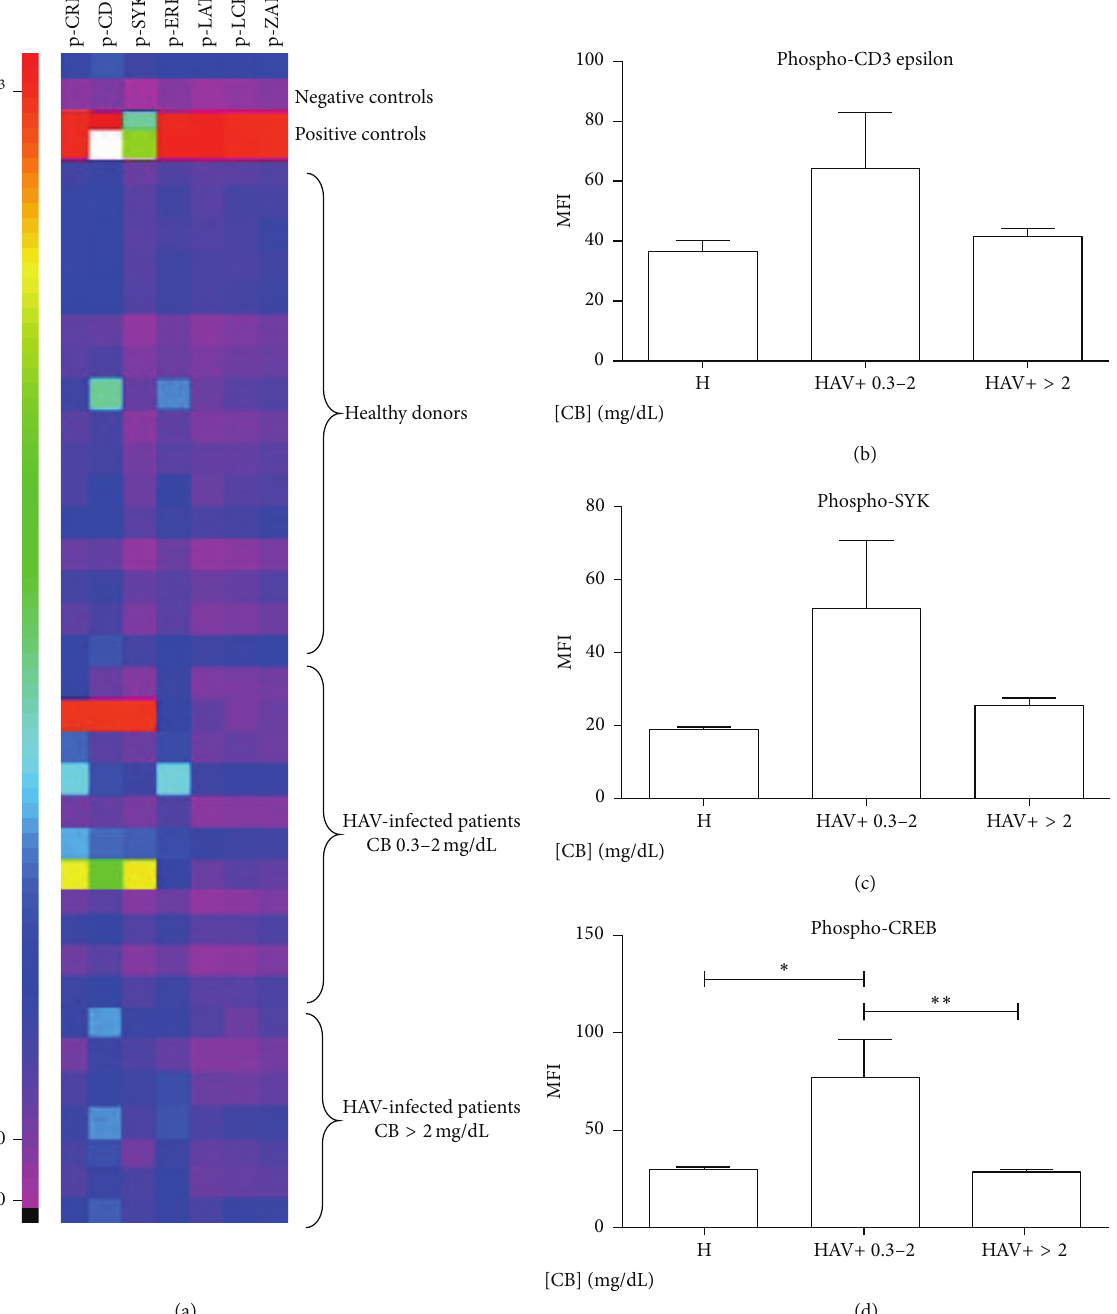
Figure 2: CD4+ TLs from HAV-seropositive patients with CB levels greater than 2 mg/dL have a lower degree of CD3 epsilon, CREB, and SYK phosphorylation. TCR-related intracellular signals were evaluated in CD4+ TLs lysates from pediatric patients and healthy donors by MAGPIX Technology. Representative Heat map (MFI) is shown in (a). The medians of the MFI and SD of phosphorylated CD3 epsilon (b), phosphorylated SYK (c), and phosphorylated CREB (d) from HAV+ patients with CB 0.3–2 mg/dL ( 𝑛 = 11 ), HAV+ patients with CB > 2 mg/dL ( 𝑛 = 7 ), and healthy (H) donors ( 𝑛 = 16 ) are shown. Nonparametric Kruskal-Wallis for comparison between groups was used to calculate statistical significance. 𝑃 < 0.05 was considered statically significant. ∗ 𝑃 < 0.05 and ∗∗ 𝑃 < 0.001